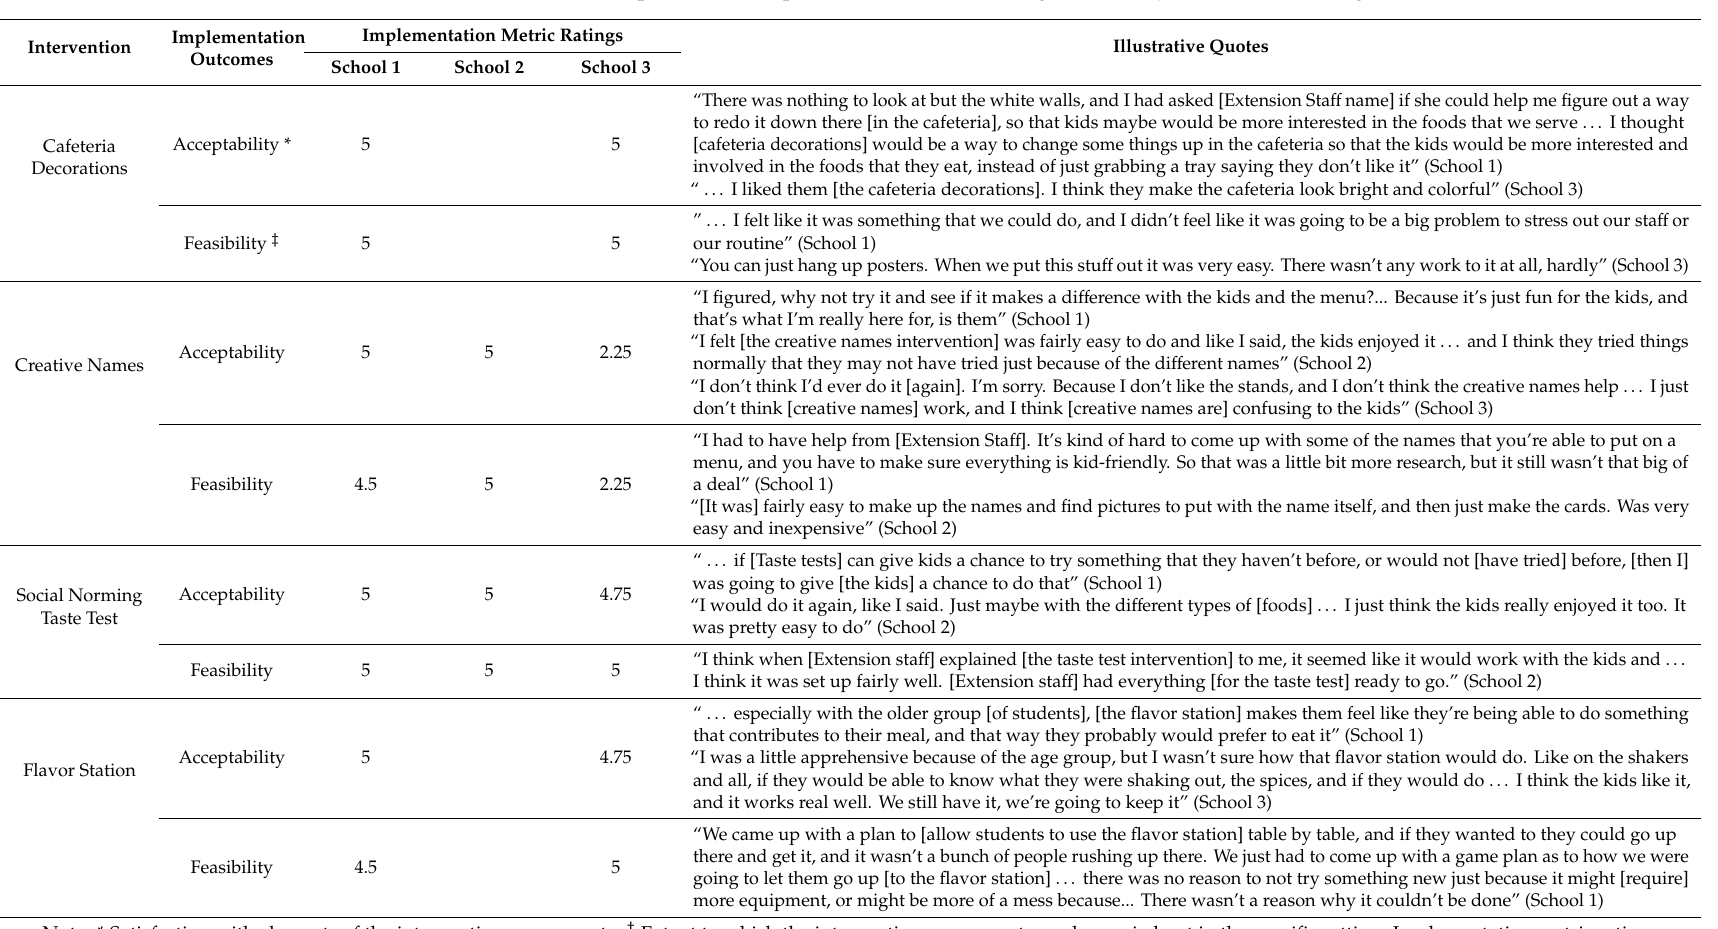
Table 7. School nutrition services sta ff quantitative implementation metric ratings and their justification of ratings ( n =